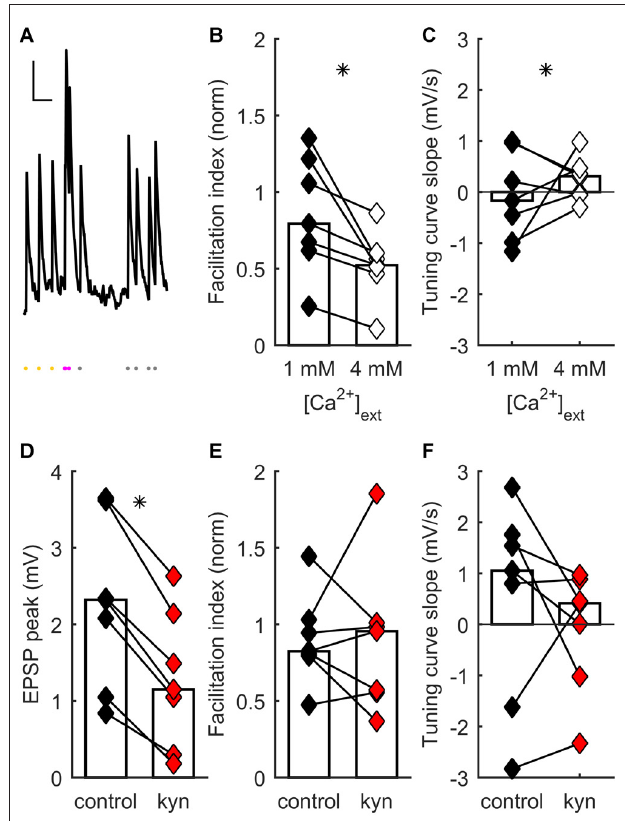
FIGURE 1 | Short-term synaptic plasticity (STP) diversity depends on presynaptic mechanisms. (A) Example of recording of post-synaptic potential (PSP) responses to ongoing thalamocortical (TC) stimulation (mean of eight traces). Scale bars: 300 ms, 0.5 mV. Dots at bottom, times of stimulation. Stimulation at constant frequency shown in yellow; stimulation just after transition to irregular train, in magenta; later irregular stimulation, in gray. The facilitation index was obtained by dividing the average response just after switching to irregular stimulation (magenta dots) by the average steady-state response at constant frequency (yellow dots). (B) Facilitation index dependance on extracellular [Ca 2 + ]. In (B–E) , each connected pair of points is one recording. Bars represent population median. Asterisks denote statistically significant difference between distributions (tests are indicated in main text). Facilitation index values decrease and become more narrowly distributed as [Ca 2 + ] increases. (C) Tuning curve slope (TCS) dependance on extracellular [Ca 2 + ]. Distribution becomes narrower as [Ca 2 + ] increases. (D) Kynurenic acid partial block of postsynaptic glutamate receptors decreases EPSP size. (E) Kynurenic acid application has no systematic effect on facilitation index. (F) Kynurenic acid has no systematic effect on